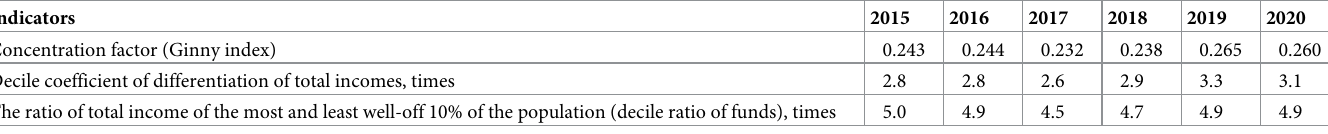
Table 1. Indicators characterizing the distribution of households by income level.